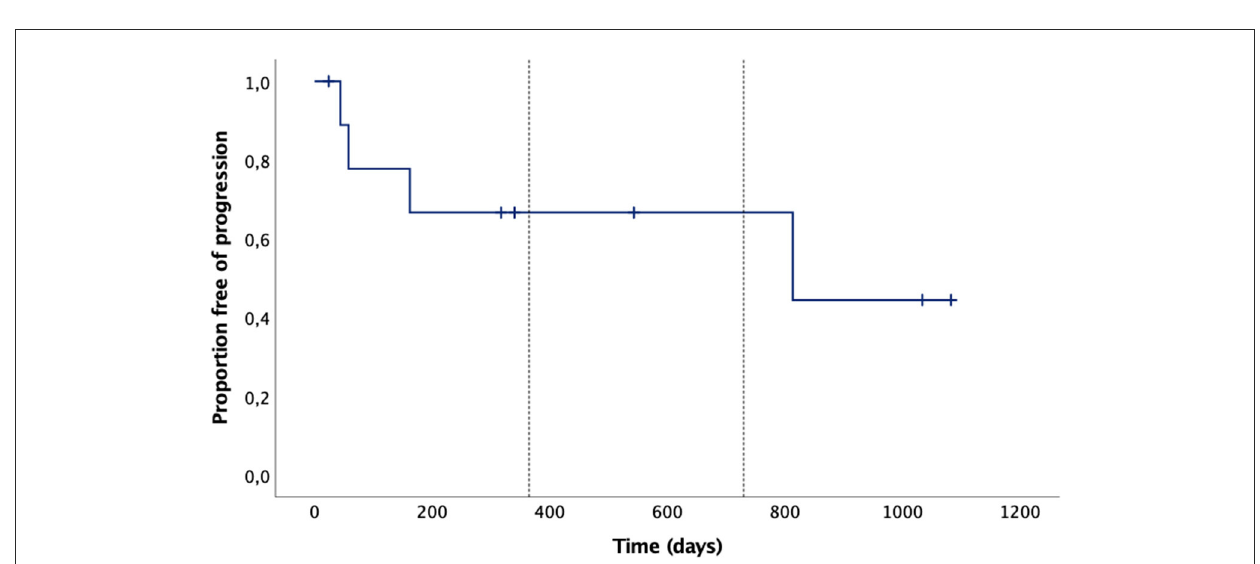
FIGURE4 Time to progression Kaplan-Meier curves of the 10 dogs: mean time to progression was 691 days (95%CI: 396–987), median not reached. The tick marks represent censored cases, the vertical dotted lines mark 1 and 2 years.